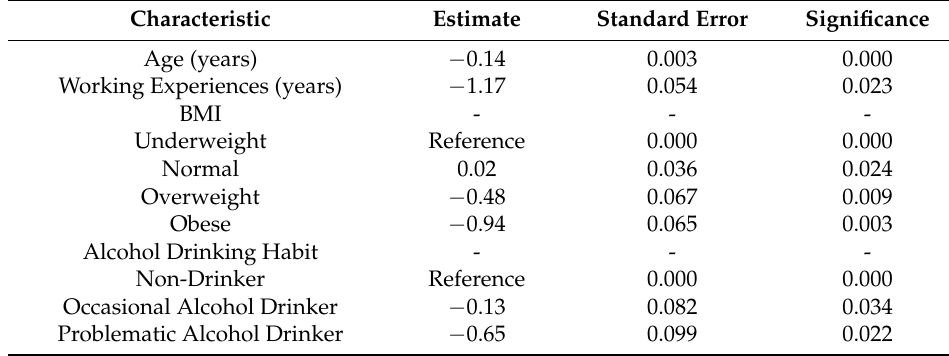
Table 5. Multivariate analysis of the relationship between musculoskeletal pain and age, BMI, alcohol drinking habits, working experience among construction workers in Hong Kong.